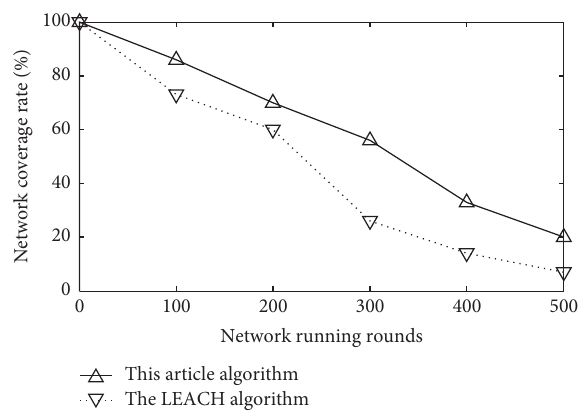
Figure 6: Energy consumption comparison in this article’s algo- rithm and the LEACH algorithm under different network running rounds (when s � 0.2).